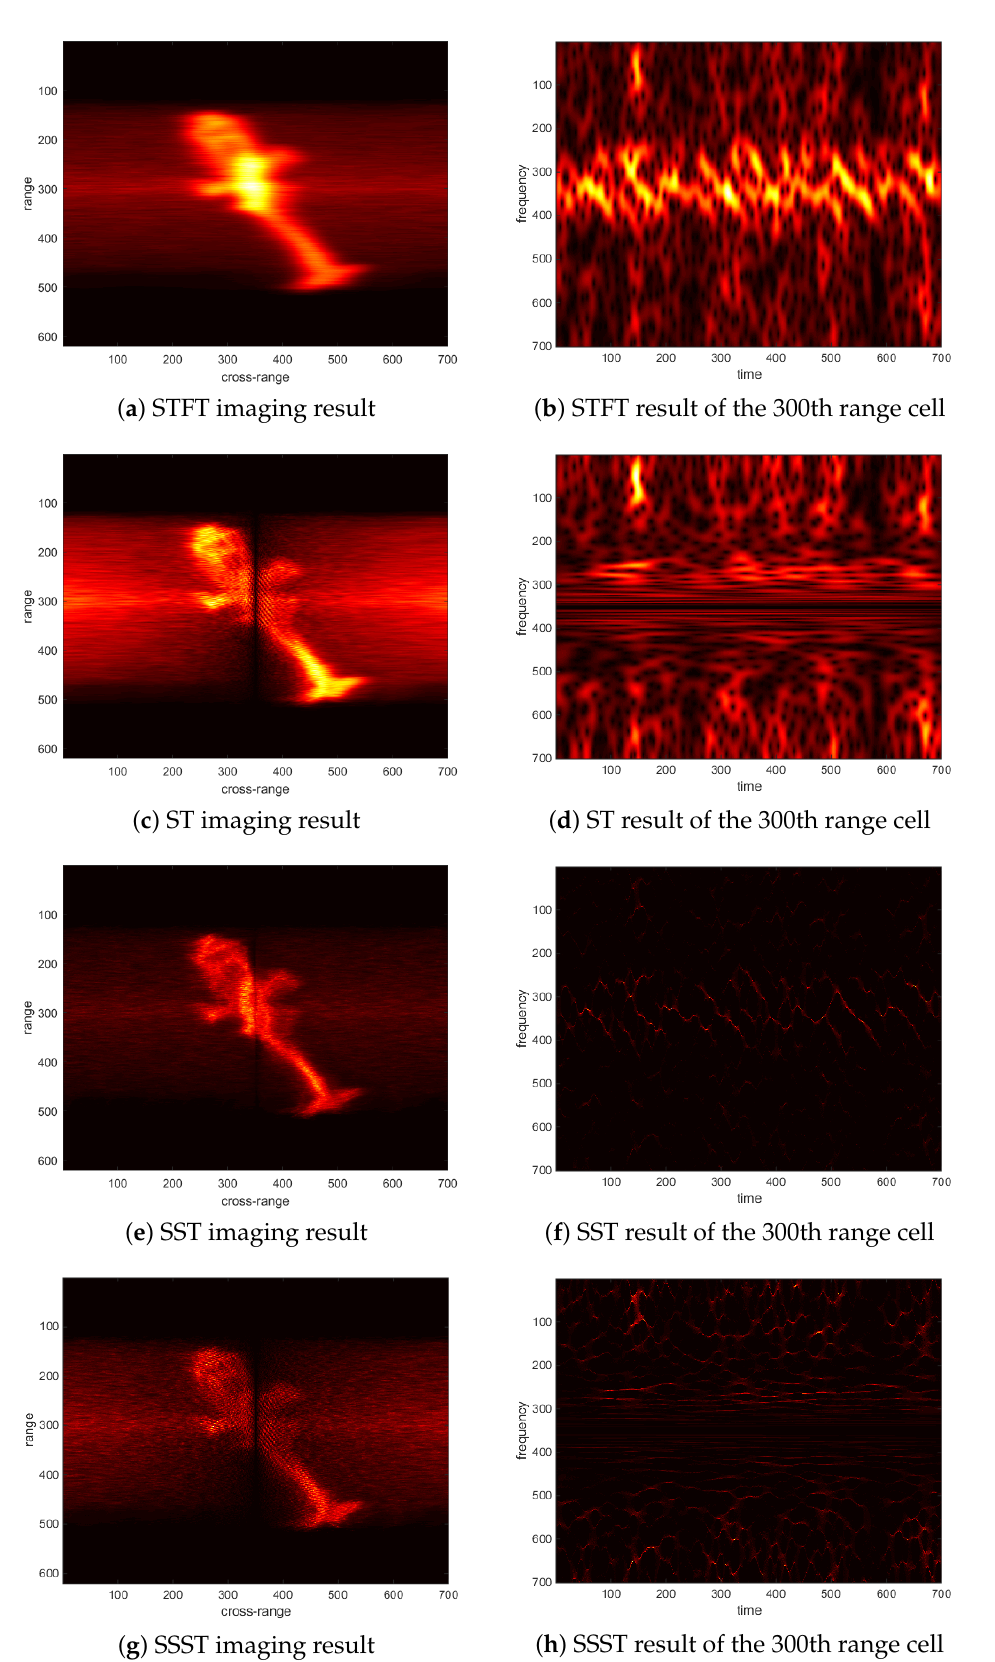
Figure 5. Results of target with a main rotor speed of 10